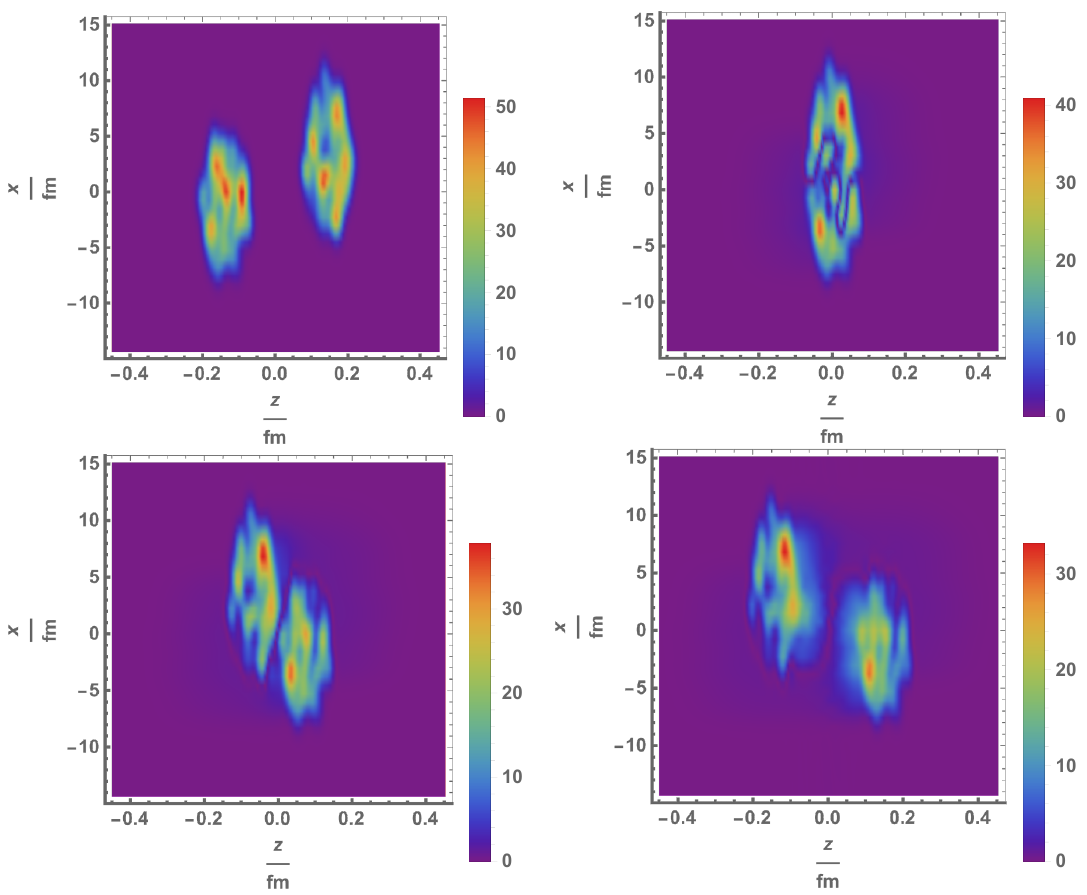
Figure 2 . The absolute value of the energy flux | T 0 i | in units of [ GeV 4 ] as a function of the longitudinal coordinate z and the transverse coordinate x , at y = 0 and at various times. From top left to bottom right, the y = 0 slices depict the momentum density at t = − 0 . 144 fm/ c , t = 0 fm/ c , t = 0 . 068 fm/ c and t = 0 . 144 fm/ c